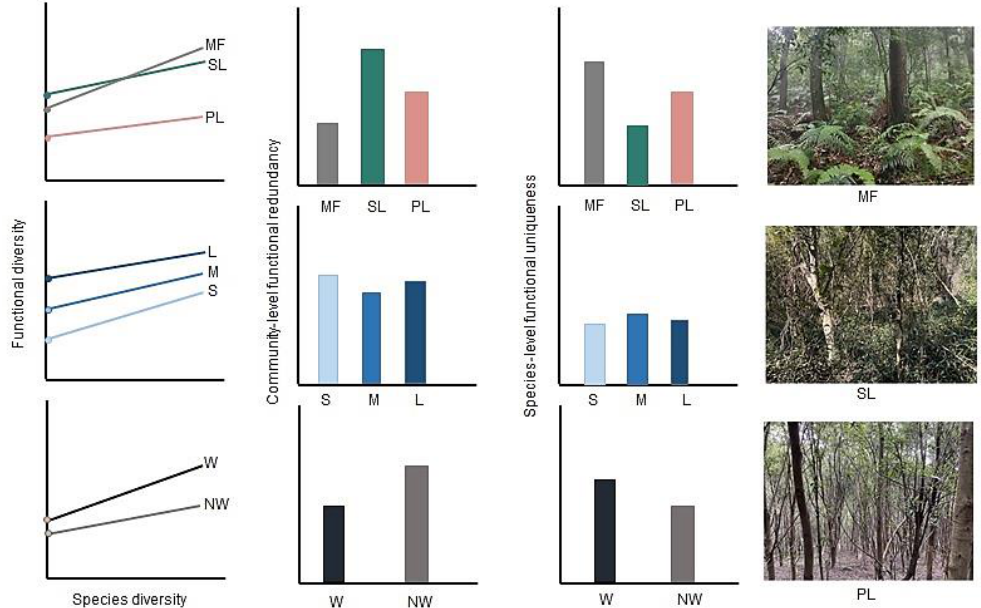
Figure 1. Hypothesized patterns of variations in community-level functional redundancy, species- level functional uniqueness, and the resultant variations in the species and functional diversity relationship concerning habitat disturbance (MF = mature forests, SL = shrublands and PL = plan- tations), spatial scale (L = large scale, M = medium scale and S = small scale) and vegetation layers (W = woody layers and NW = non-woody layers).